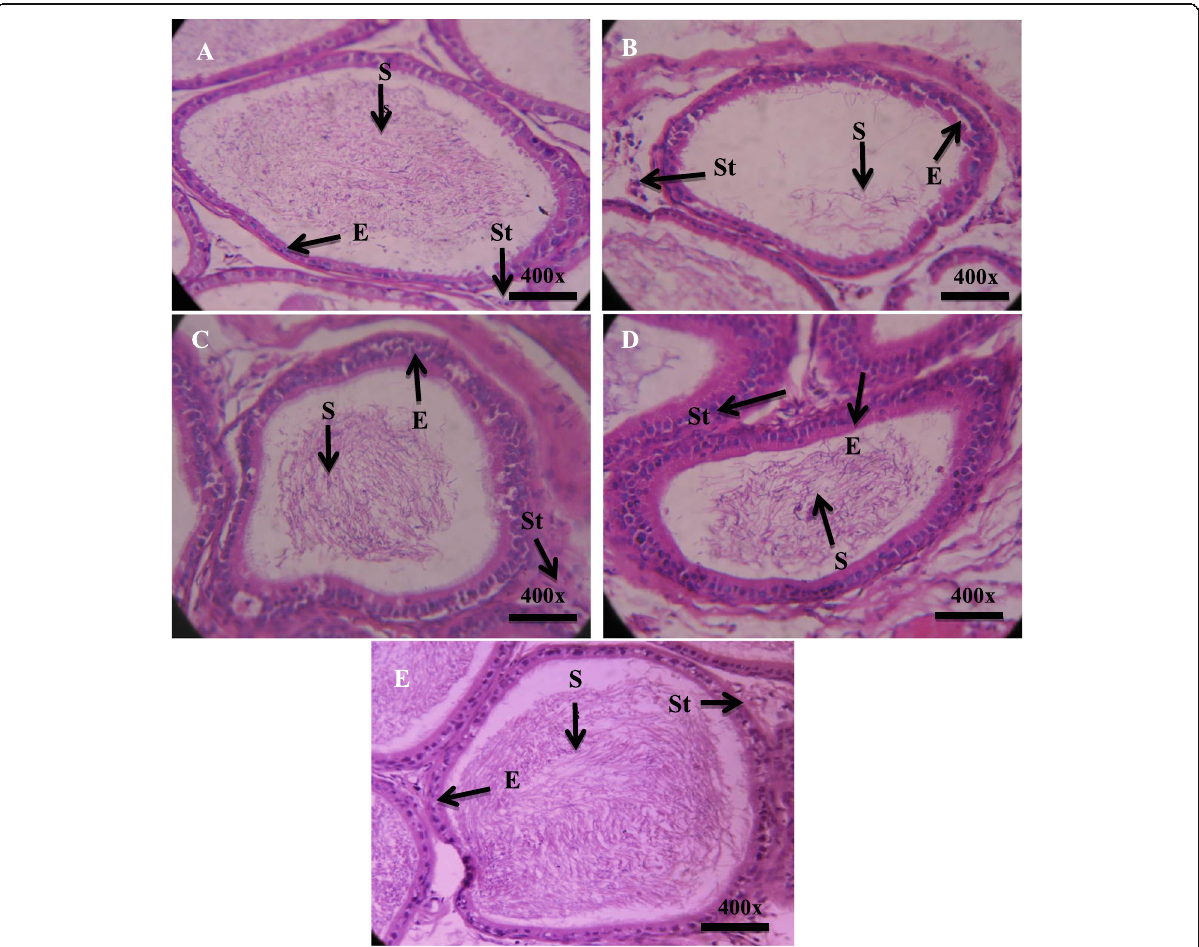
Fig. 3 Photomicrograph of seminiferous tubules of adult male rat testes. Control group showing compact tubules, spermatid inside lumen, normal germ cell proliferation in epithelium ( a ), Mercury group shows tubules with empty lumen degenerated epithelial layer and increased interstitial spaces ( b ). Vitamin C-treated showing less damage to epithelium lumen filled with spermatid and interstitial spaces ( c ). C. album co- treated shows minimal damage to epithelium and tubules, with less interstitial spaces ( d ). Magnification × 40. SP, spermatogonia; ES, elongated spermatids; IS, interstitial space; E, epithelium; × 40 by × 10 = ×